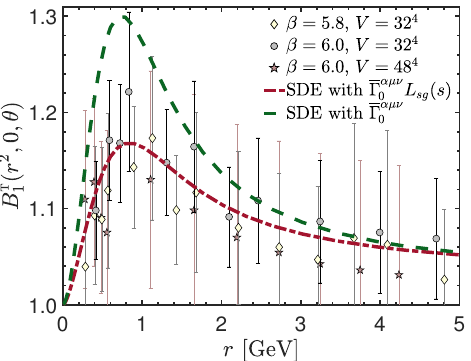
( r 2 ,0, θ ) , of the classical form factor of the ghost–gluon vertex in the Figure 14. Soft gluon limit, B T 1 Taylor scheme. The points correspond to the lattice data of Reference [42,43]. The red dot-dashed line shows the SDE solution with the three-gluon vertex dressed according to Equation (78), while the green dashed represents the SDE solution with tree-level three-gluon